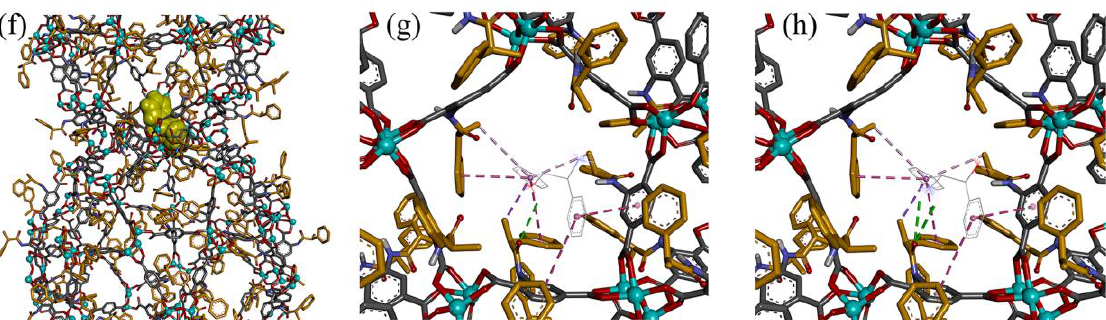
Figure 7. Two adjacent cages, ST28 (left) and ST20 (right), of MIL − 101 − Ppa ( a ) and NH 2 − MIL − 101 − Ppa ( b ) were used for docking calculations, where light-gray beads represent the search space for possible binding poses. Inclusion complexes of 2-amino-1,2-diphenylethanol isomers (space-filling models in yellow) with MIL − 101 − Ppa ( c ) and interaction networks between the binding partners for the R ( d ) and S ( e ) isomers. The structures in ( f – h ) are similar to ( c – e ) but for binding with NH 2 − MIL − 101 − Ppa. All pictures were generated by Biovia Discovery studio visualizer software. Ten representative binding poses are shown in panels ( d – h ) for a clear depiction of interaction networks. Al ions are shown with cyan balls. Carbon atoms in MIL − 101 linkers are colored in gray, while they are orange in the Ppa group.